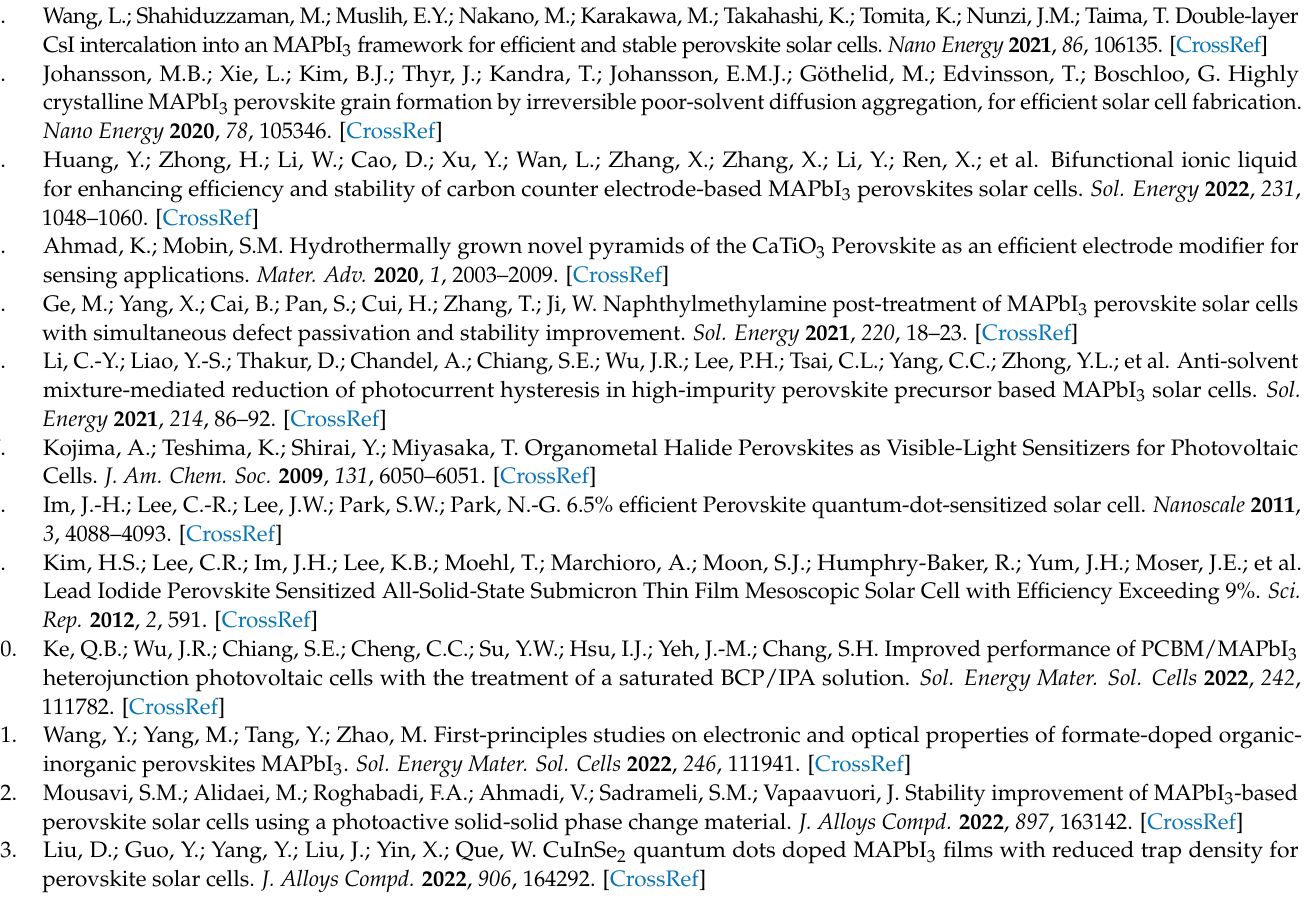
parameters, Table S5: Photovoltaic parameters, Table S6: Photovoltaic parameters, Table S6: Photovoltaic parameters, Table S7: Photovoltaic parameters, Table S8: Photovoltaic parameters, Table S9: Photovoltaic parameters, Figure S1: Flow chart, Figure S2: J-V curve